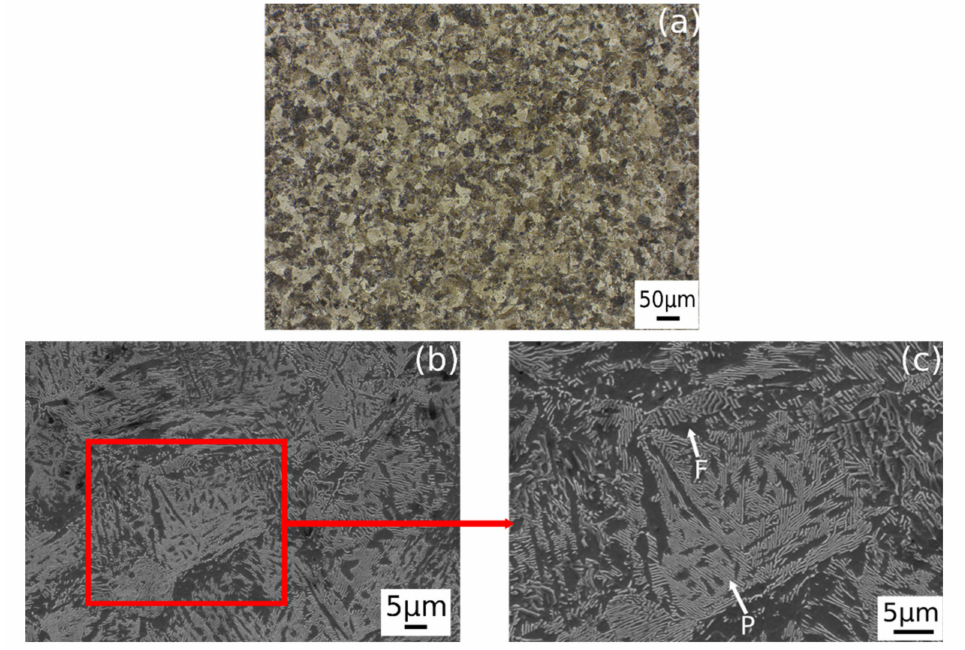
Figure 5. Optical ( a ) and SEM ( b , c ) micrographs showing the microstructure after annealing at 870 ◦ C. Figure 6 refers to the microstructure of the material after water quenching, before tempering. As expected, a complete martensitic microstructure (M) was obtained. SEM images (Figure 6b,c)